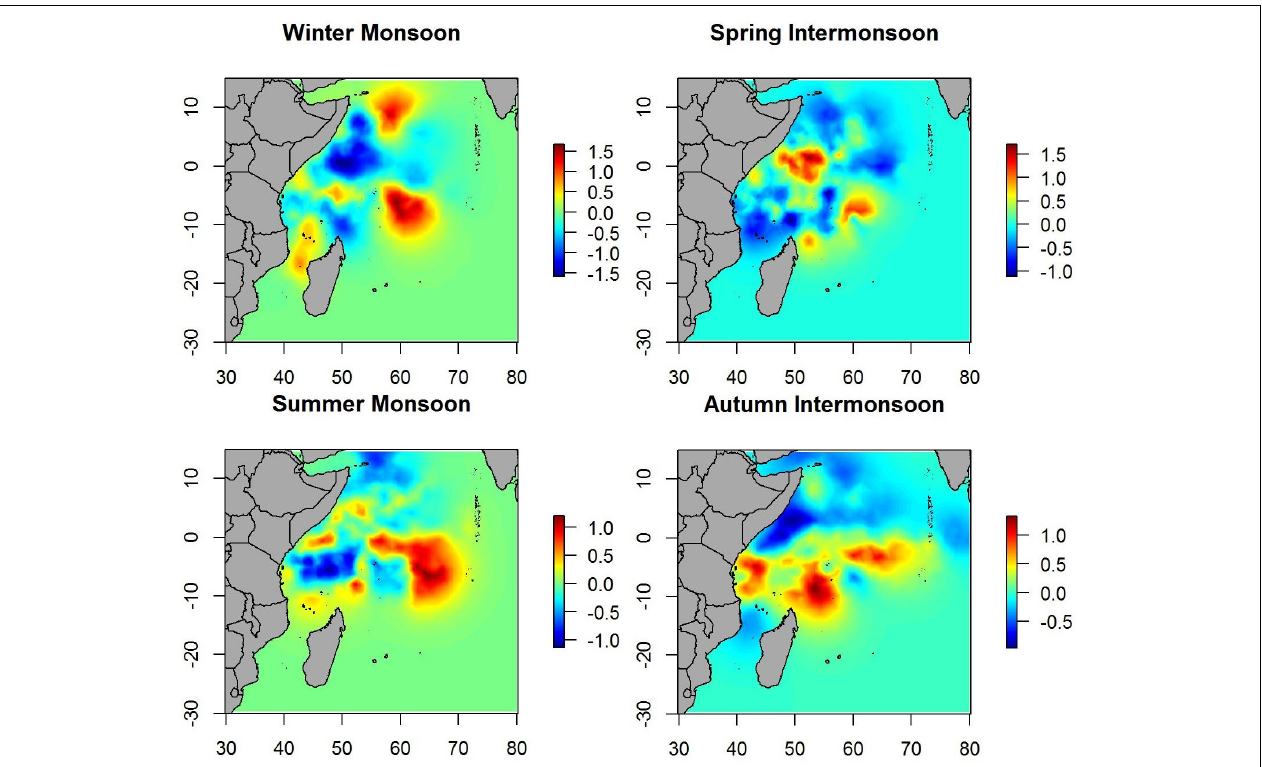
FIGURE 4 | Maps of the posterior mean of the spatial effect for tuna model in different seasons.